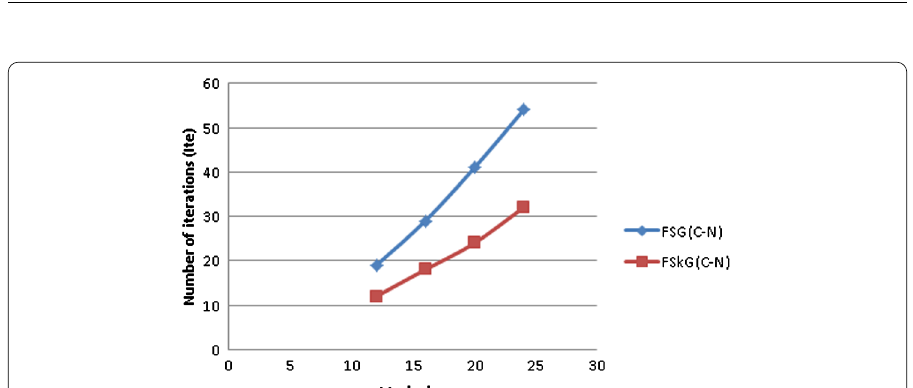
point Crank–Nicolson finite difference approximation by skewing clockwise an angle of 45 0 with respect to the standard grids in solving the two-dimensional second-order hy- perbolic telegraph equation of fractional order. The derived numerical iterative scheme is unconditionally stable, and its stability and convergence are proven by the Fourier anal- ysis. A comparison of both the numerical iterative schemes has been given in terms of computational complexities of the algorithm and verified with the help of examples. Ex- perimental numerical results show that the FSkG(C-N) iterative method not only has